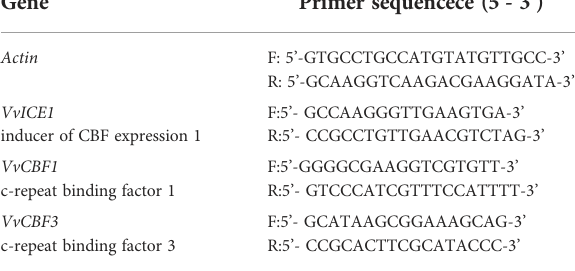
TABLE 1 Sequences for primers used in qRT-PCR. Gene Primer sequencece (5 ’ - 3 ’